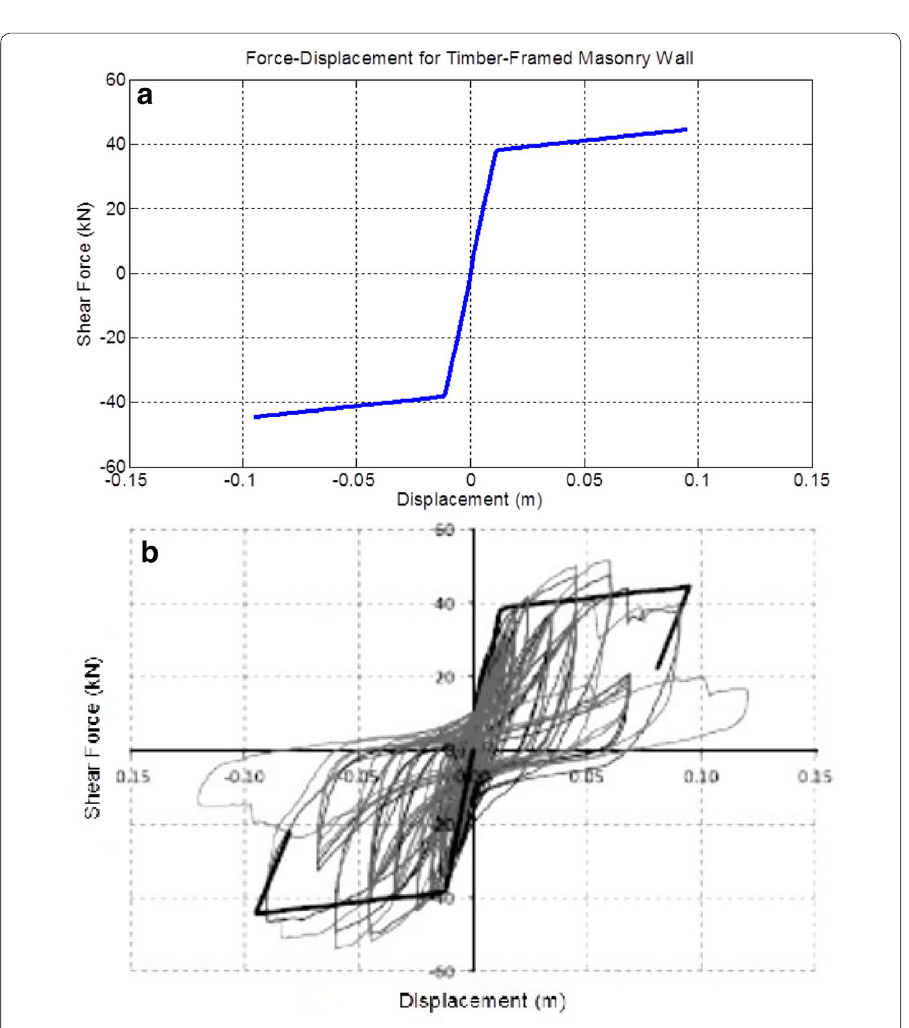
Fig. 12 Comparison of the pushover curves from the methodology adopted by Kouris and Kappos (2014) a and the experimental results by Meireles et al. (2012) b